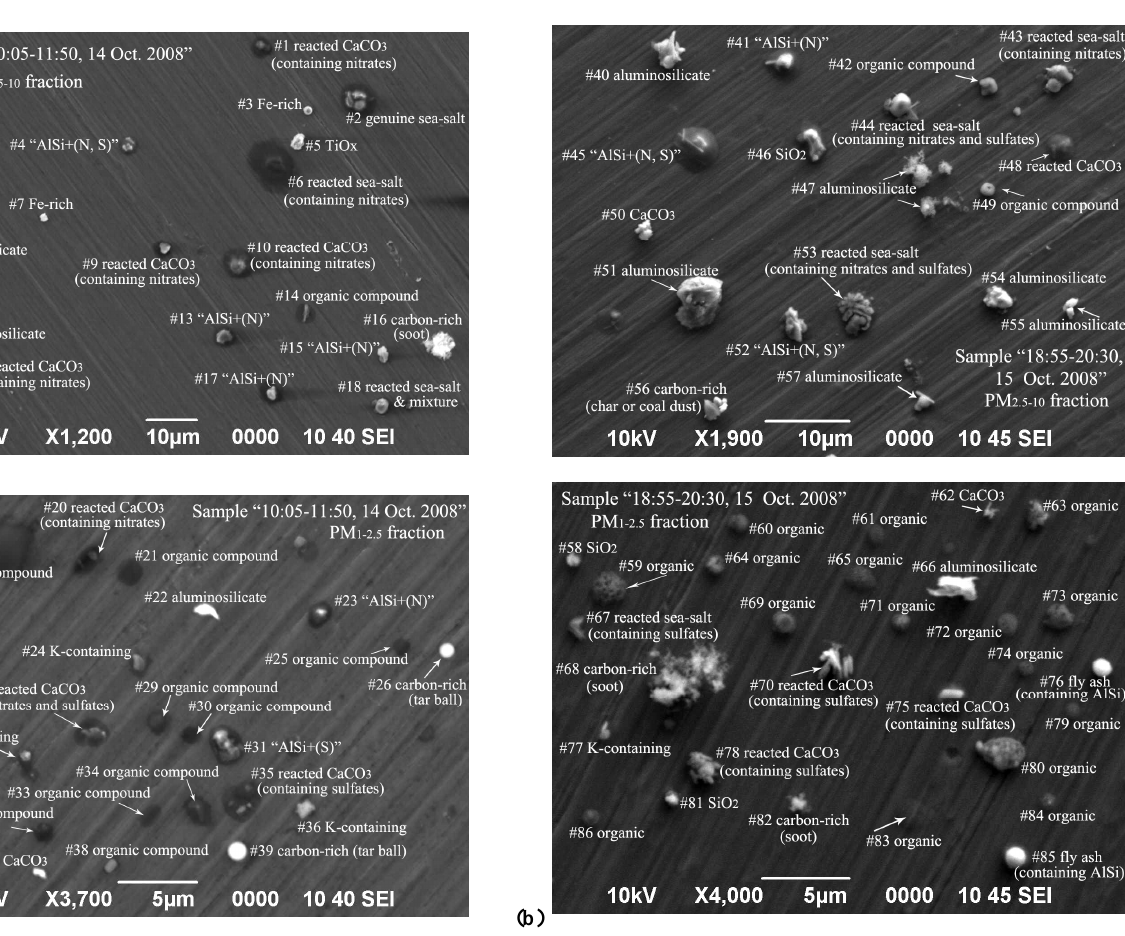
Fig. 3a. Typical SEM images of urban aerosol particles collected in Incheon, Korea. (For convenience, aluminosilicate is denoted as “AlSi-containing”. “(N)” notation represents particles contain- ing nitrates; “(S)” notation represents particles containing sulfates; “(N, S)” notation represents particles containing both nitrates and sulfates. (C, N, O, S) notation represents the mixture of carbona- ceous and (NH 4 ) 2 SO 4 /NH 4 HSO 4